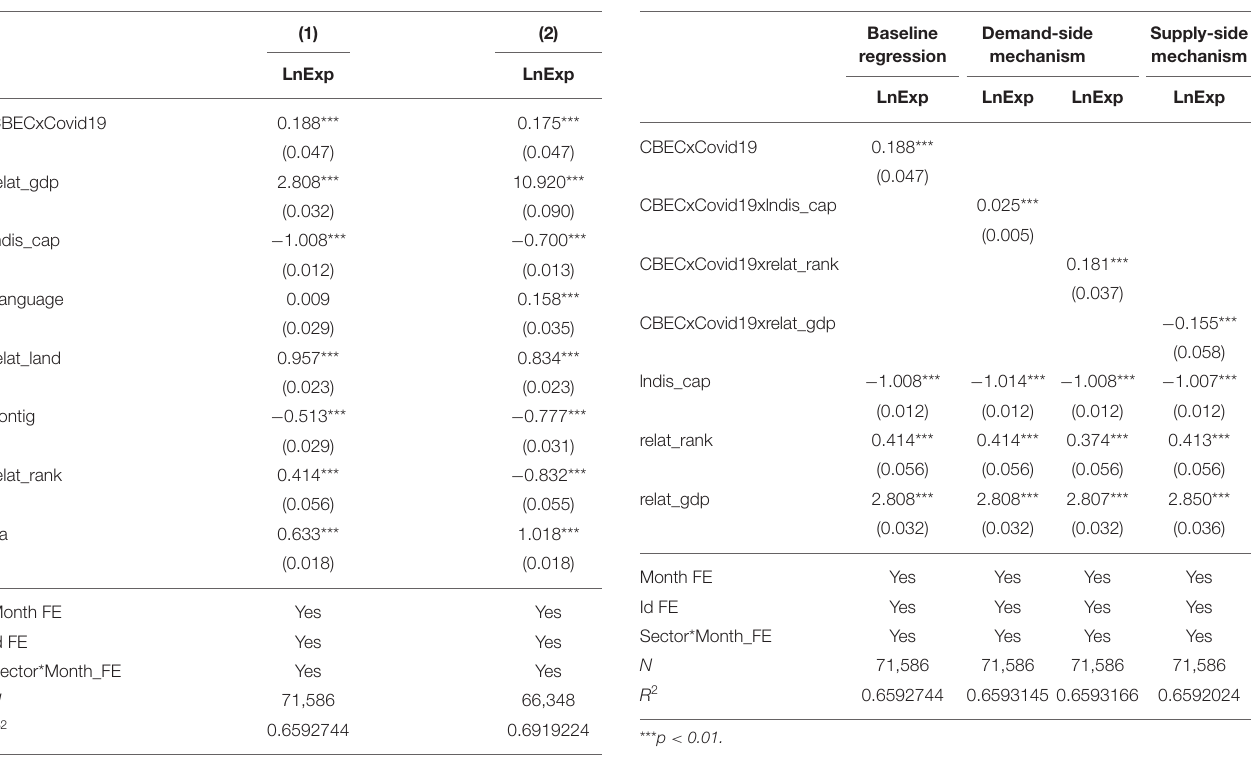
TABLE 5 | Regression results of the robustness test based on subsamples. TABLE 6 | Regression results of the mechanism